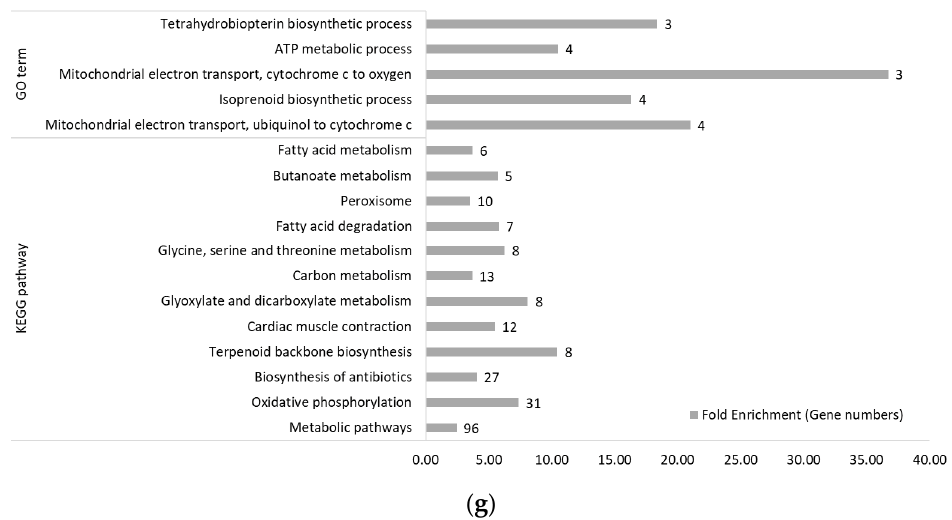
Figure 7. Gene ontology (GO) biological processes and KEGG pathway overrepresentation ( p < 0.05, fold enrichment > 2 and FDR < 0.2) for within-line comparisons. ( a ) GO terms and KEGG pathways significantly enriched by down-regulated genes in the LTLC comparison at AH. ( b ) GO terms and KEGG pathways significantly enriched by up-regulated genes in the FTFC comparison at AH. ( c ) GO terms and KEGG pathways significantly enriched by down-regulated genes in the FTFC comparison at AH. ( d ) GO terms and KEGG pathways enriched by up-regulated genes in the LTLC comparison at CH&NDV. ( e ) GO terms and KEGG pathways significantly enriched by down-regulated genes in the LTLC comparison at CH&NDV. ( f ) GO terms and KEGG pathways significantly enriched by up-regulated genes in the FTFC comparison at CH&NDV. ( g ) GO terms and KEGG pathways significantly enriched by down-regulated genes in the FTFC comparison at CH&NDV.